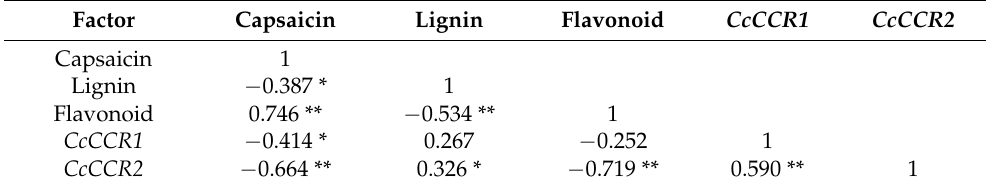
Figure 8. Relative expression of CcCCRs. G means pericarp; T means placenta. Table 3. Correlation coefficients between CcCCRs relative expression level and metabolite content in Huangdenglong.